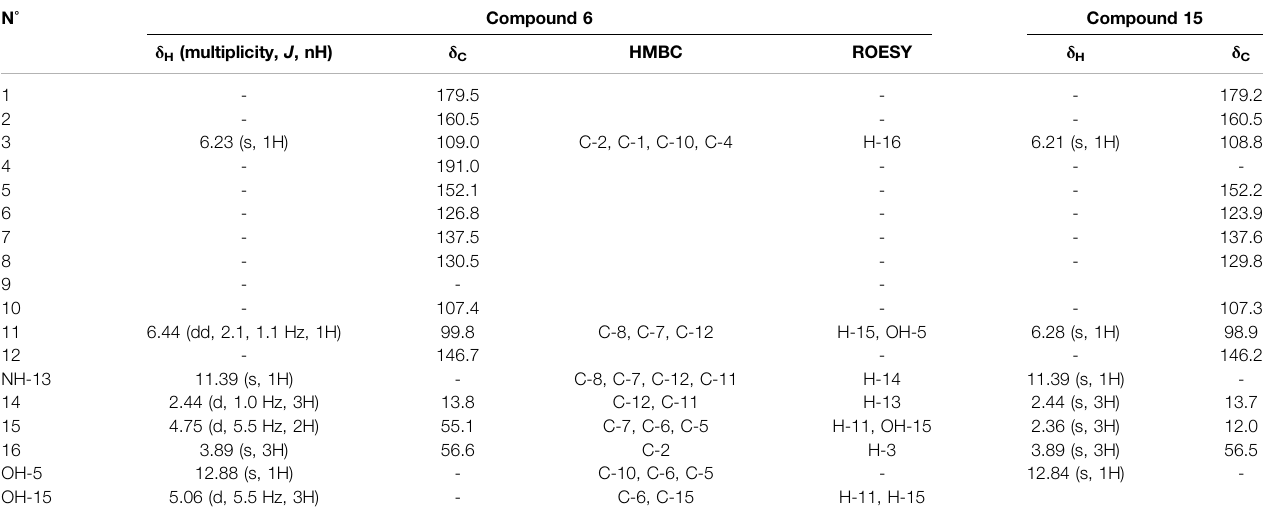
TABLE 3 | NMR chemical shifts of compound 6 and 15 in DMSO- d 6 at 600 MHz. N ° Compound 6 Compound 15 δ H (multiplicity, J ,